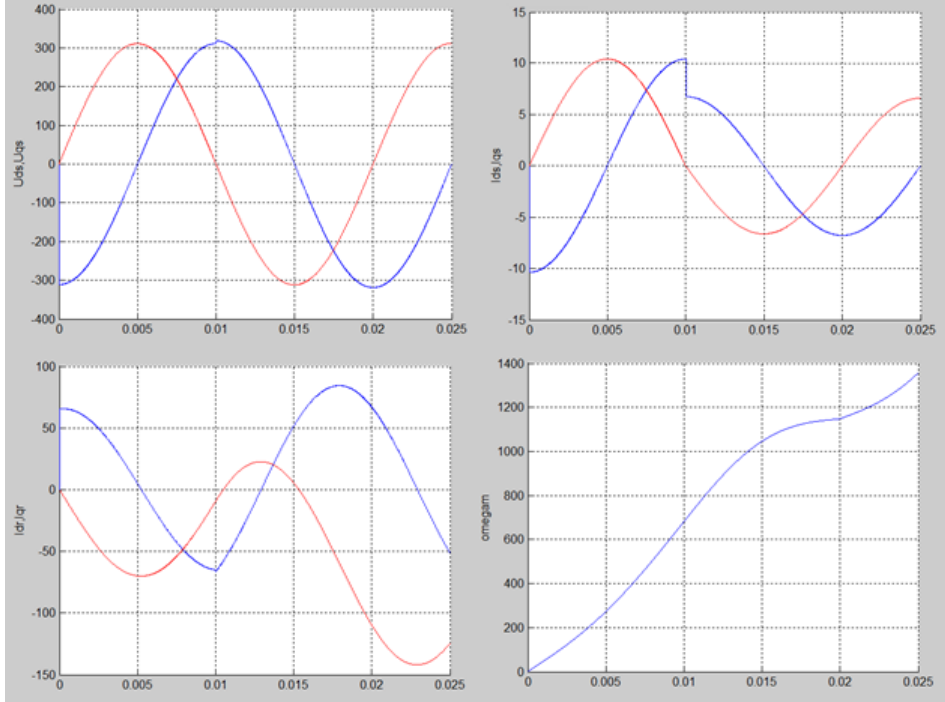
Figure 2. Charts of the CS with observer operational results at variable disturbances, clockwise: voltage “dq” stator, currents “dq” stator, shaft rotation speed, currents “dq”